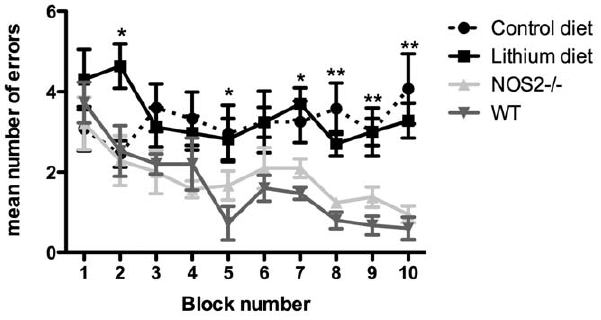
Figure 1. Lithium does not improve outcomes on the radial- arm water maze spatial memory task. APPSwDI/NOS2 2 / 2 mice receiving either control diet (N=8, 4 male and 4 female) or lithium supplemented diet (N=11, 4 female and 7 male), NOS2 2 / 2 (N=7, 3 female and 4 male) and wildtype mice (N=7, 3 female and 4 male) aged 12 months were tested on the two-day radial-arm water maze task. Data are shown as mean number of errors per block number. Each block comprises three trials. * indicates P , 0.05, ** indicates P , 0.01 for both the APPSwDI/NOS2 2 / 2 treatment groups when compared to NOS2 2 / 2 and wildtype mice for each block number.